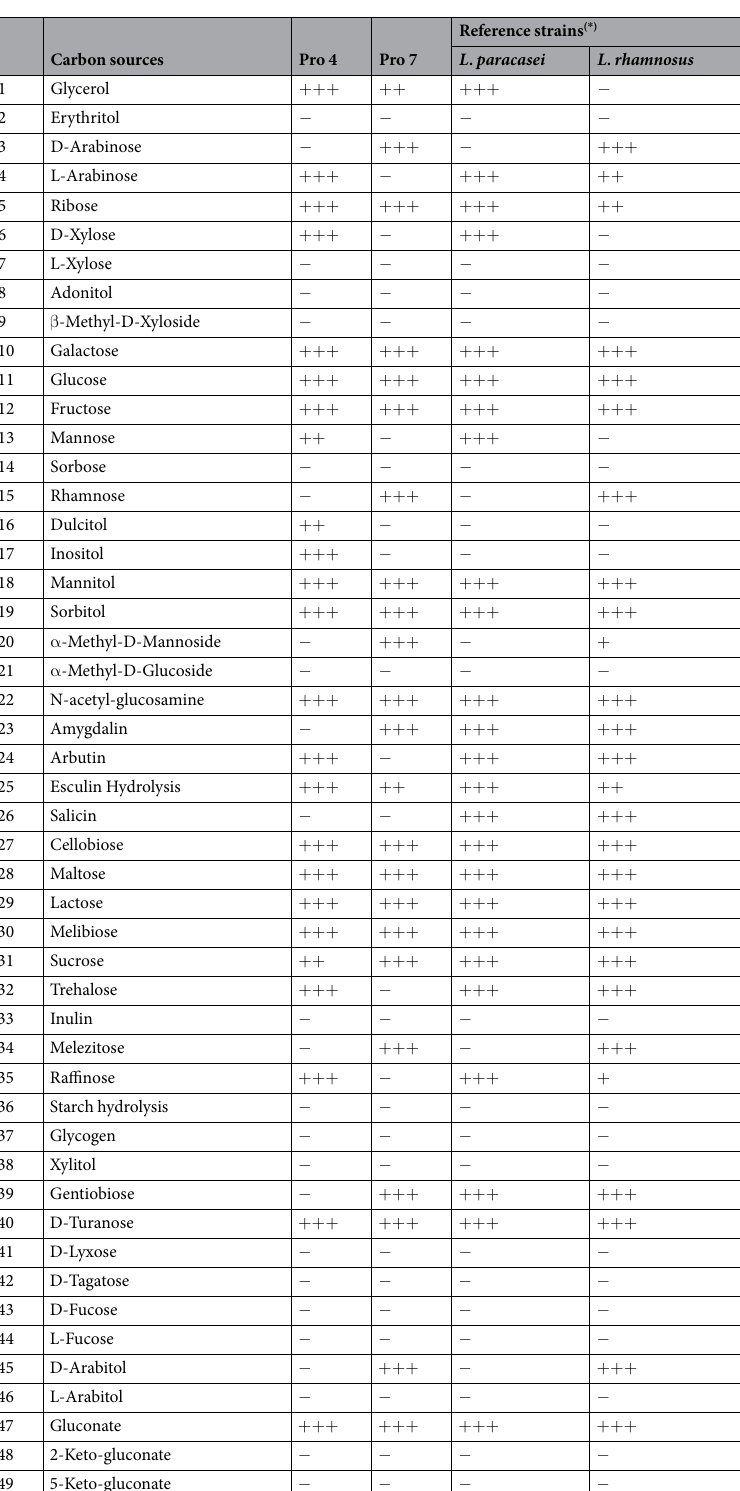
Table 2. API 50CHL carbohydrate profile for selected probiotic strains. Notes: Carbohydrate fermentation profiles were applied according to API 50 CHL strips. The Score of the result tests: − negative growth; + weak growth; ++ good growth, +++ very good growth. ( * )Reference strains of Lactobacillus rhamnosus